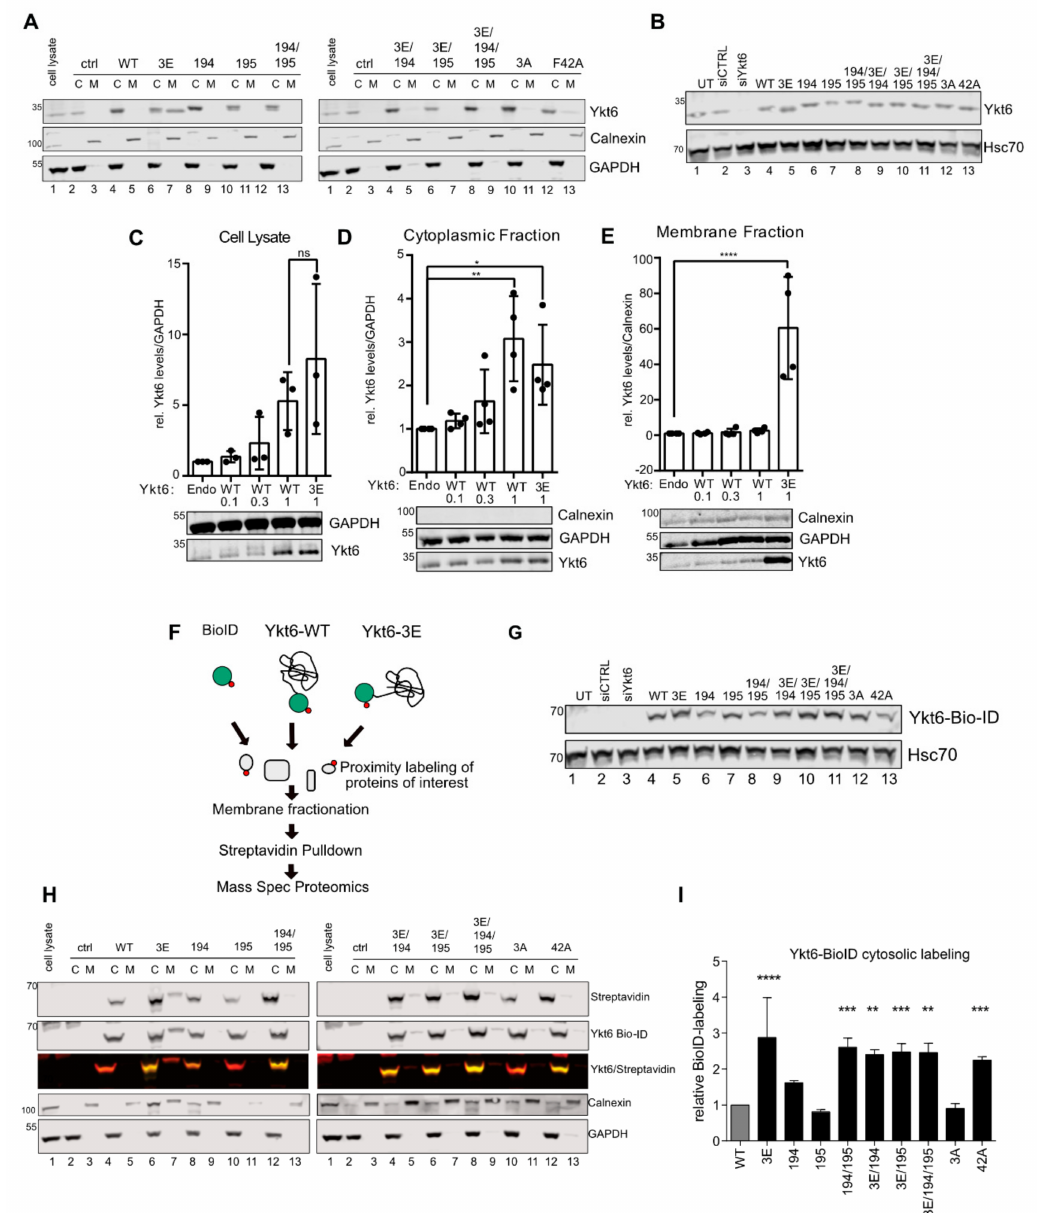
Figure 3. SNARE phosphorylation sites determine membrane attachment and auto-inhibited conformation. ( A ) Representative immunoblot of cell fractionation of di ff erent Ykt6 mutant constructs transfected in Hek293T cells and stained with Ykt6 and fraction markers GADPH for cytoplasmic (C) and Calnexin for membrane (M) fraction ( n = 4). ( B ) Representative immunoblot of Ykt6 knockdown and overexpression of di ff erent Ykt6 mutant constructs with Hsc70 as a loading control. ( C ) Representative immunoblot and quantification of overexpressed Ykt6-WT construct in three di ff erent concentrations (0.1 µ g, 0.3 µ g, and 1 µ g), along with overexpressed Ykt6-3E construct and endogenous Ykt6 from three biological replicates. ( D ) Representative blot and quantification of endogenous and overexpressed Ykt6-WT (0.1 µ g, 0.3 µ g, and 1 µ g), 3E (1 µ g) in the cytoplasmic fraction, n = 4 ( E ) Representative